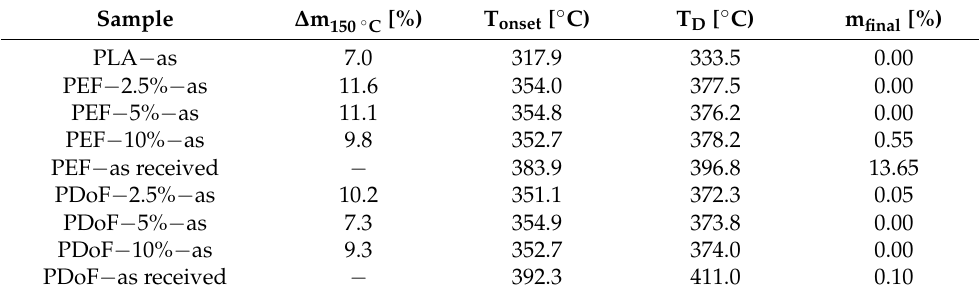
Table 5. TGA results for the PLA − as, PEF − 2.5% − as, PEF − 5% − as, PEF − 10% − as bulk PEF − as re-